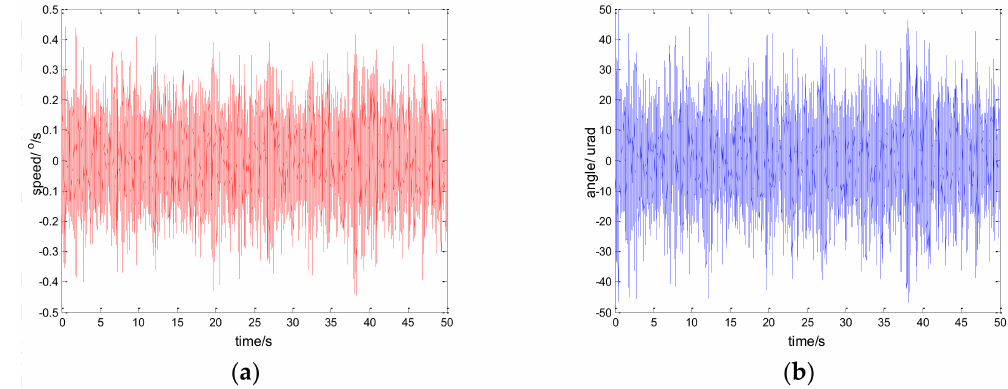
Figure 13. Experiment results of robust SMC with Euler. d = 3sin ( 2 π × 0.1 t ) : ( a ) speed; and ( b ) tracking error, RMS = 12.9125